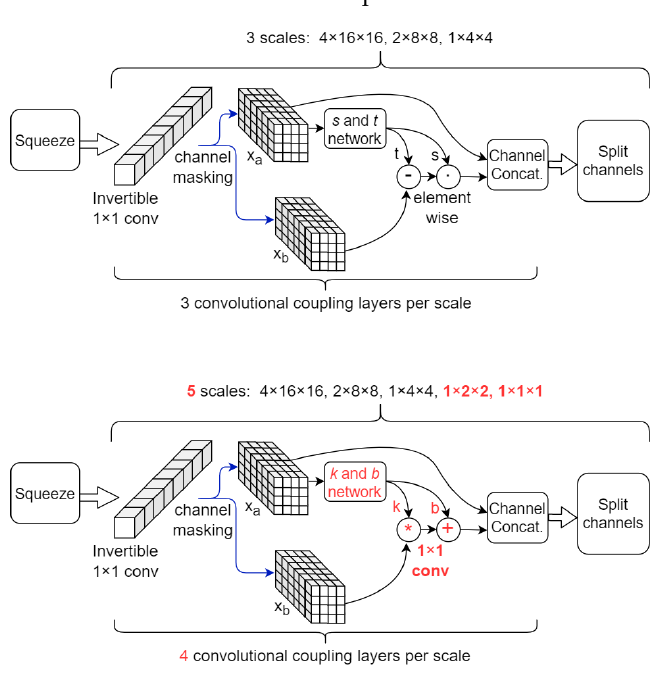
Figure 2. Comparison between baseline inner architecture ( top ) and proposed inner architecture ( bottom ) employing the novel coupling layer. Updated parts are highlighted in red. Normalization layers not depicted. Table 4. Improved NF architecture employing the novel coupling